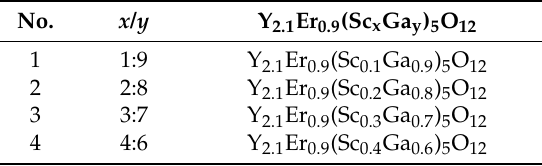
Table 1. The different proportion of Sc/Ga in four polycrystalline